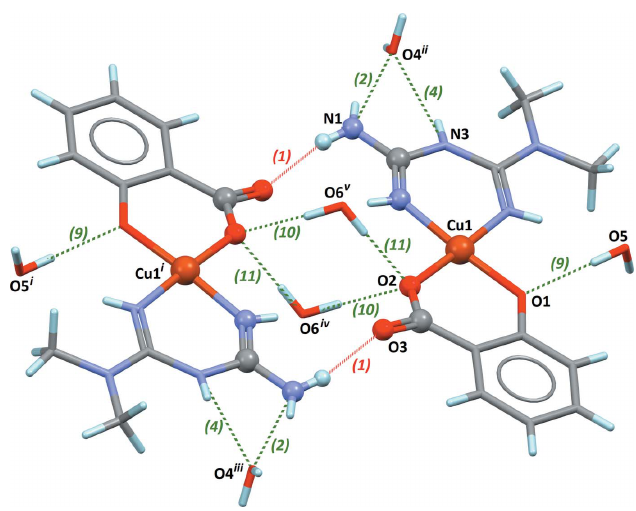
Figure 3 Ring motif R 2 (16) formed between stacks in the crystal and water 2 molecules connected to the ring. Hydrogen bonds are depicted with dashed lines and a bracketed index corresponding to entries in Table 1. The red bond (1) is that forming the ring motif. [Symmetry codes: (i) 2 (cid:5) x , 1 (cid:5) y , 1 (cid:5) z ; (ii) 1 (cid:5) x , (cid:5) y , 1 (cid:5) z ; (iii) 1 + x , 1 + y , z ; (iv) 1 (cid:5) x , 1 (cid:5) y , 1 (cid:5) z ; (v) 1 + x , y , z .]